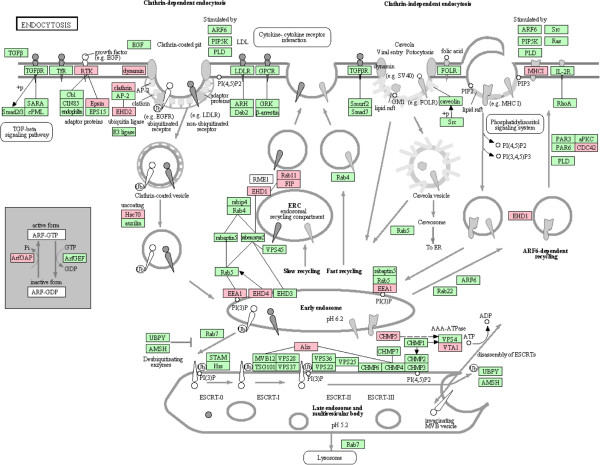
Representative KEGG pathway change of Endocytosis. Red indicate the differential proteins located in KEGG pathway.